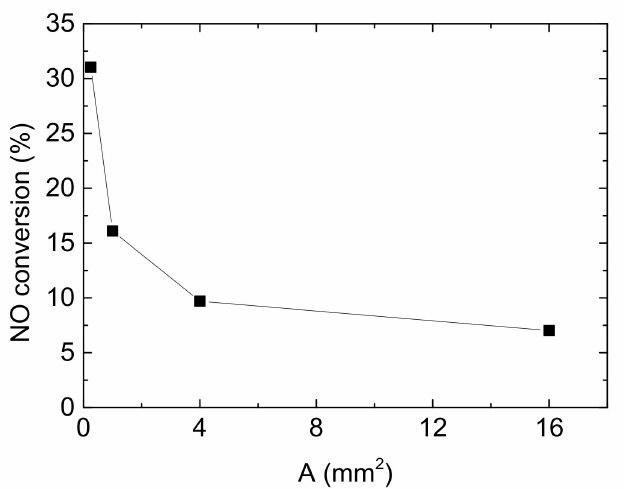
Figure 11. Influence of the cross area of channels on NO conversion (Reaction temperature T = 150 ◦ C, Concentration C NH3 = C NO = 750 ppm, C O2 = 6%, without H 2 O).